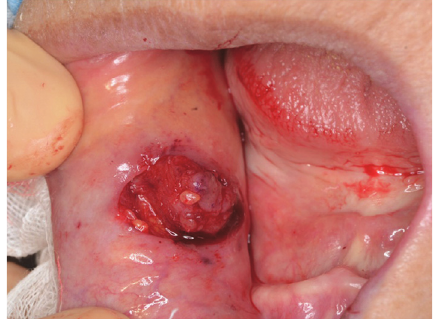
Figure 1: Intraoral finding. A submucous mass at the right buccal mucosa (arrow).